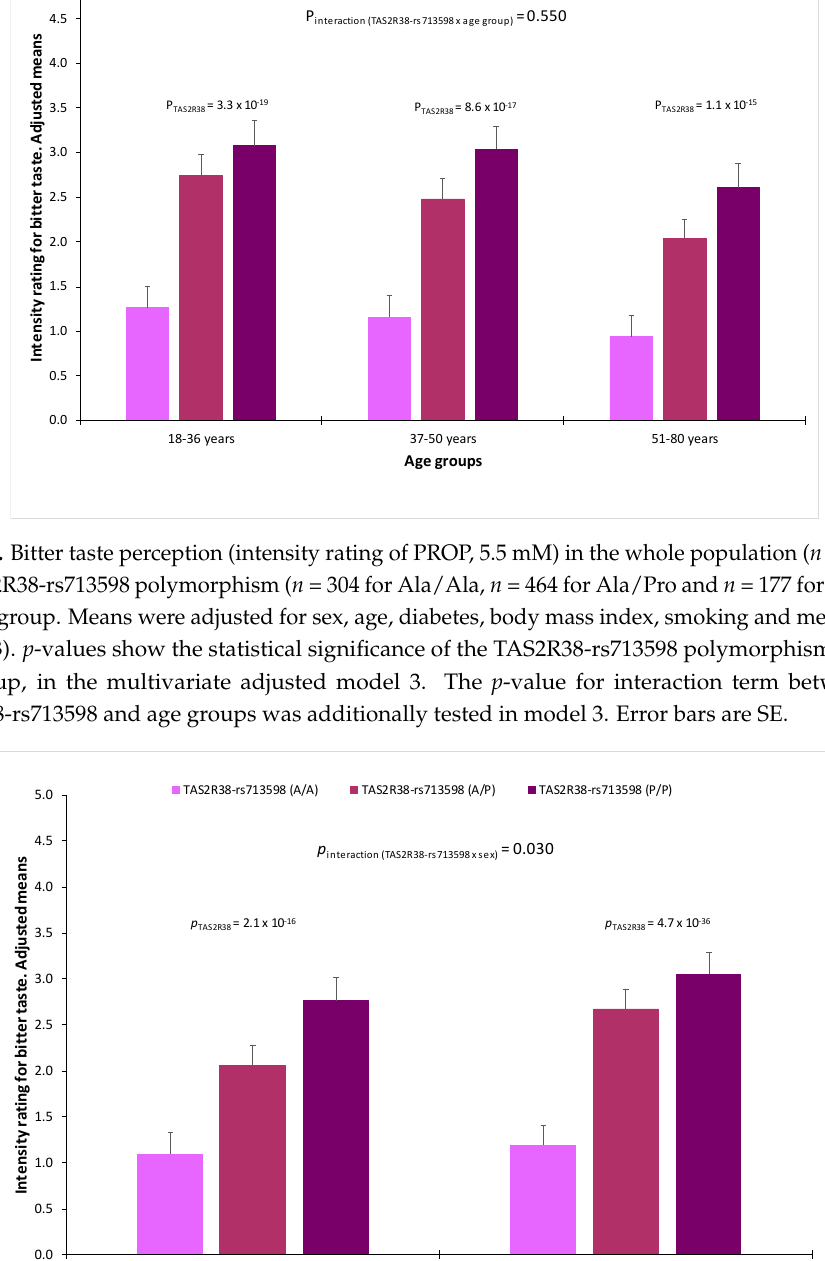
14 of 22 Figure 4. Taste perception (intensity rating) of bitter (PROP, 5.5 mM), sweet (sucrose, 400 mM) and salty (NaCl, 200 mM) in the whole population depending on the genotype for the corresponding taste polymorphism: TAS2R38 ‐ rs713598 for bitter (PROP); TAS1R2 ‐ rs35874116 for sweet; and SCNN1B ‐ rs239345 for salty. Means were adjusted for sex, age, diabetes, body mass index, smoking and medications (model 3). p ‐ values show the statistical significance for the corresponding taste polymorphism (3 genotypes as codominant) in the multivariate adjusted model 3. n = 945 for TAS2R38 ‐ rs713598; n = 949 for TAS1R2 ‐ rs35874116; and n = 927 for SCNN1B ‐ rs239345. Error bars are SE. Figure 5 shows bitter (PROP) taste perception in the whole population by the TAS2R38 ‐ rs713598 polymorphism in the three age groups. In all the age groups, the effect of the genetic polymorphism was highly statistically significant and the interaction term between the polymorphism and age did not reach the statistical significance ( p = 0.550 in the multivariate adjusted model). However, when